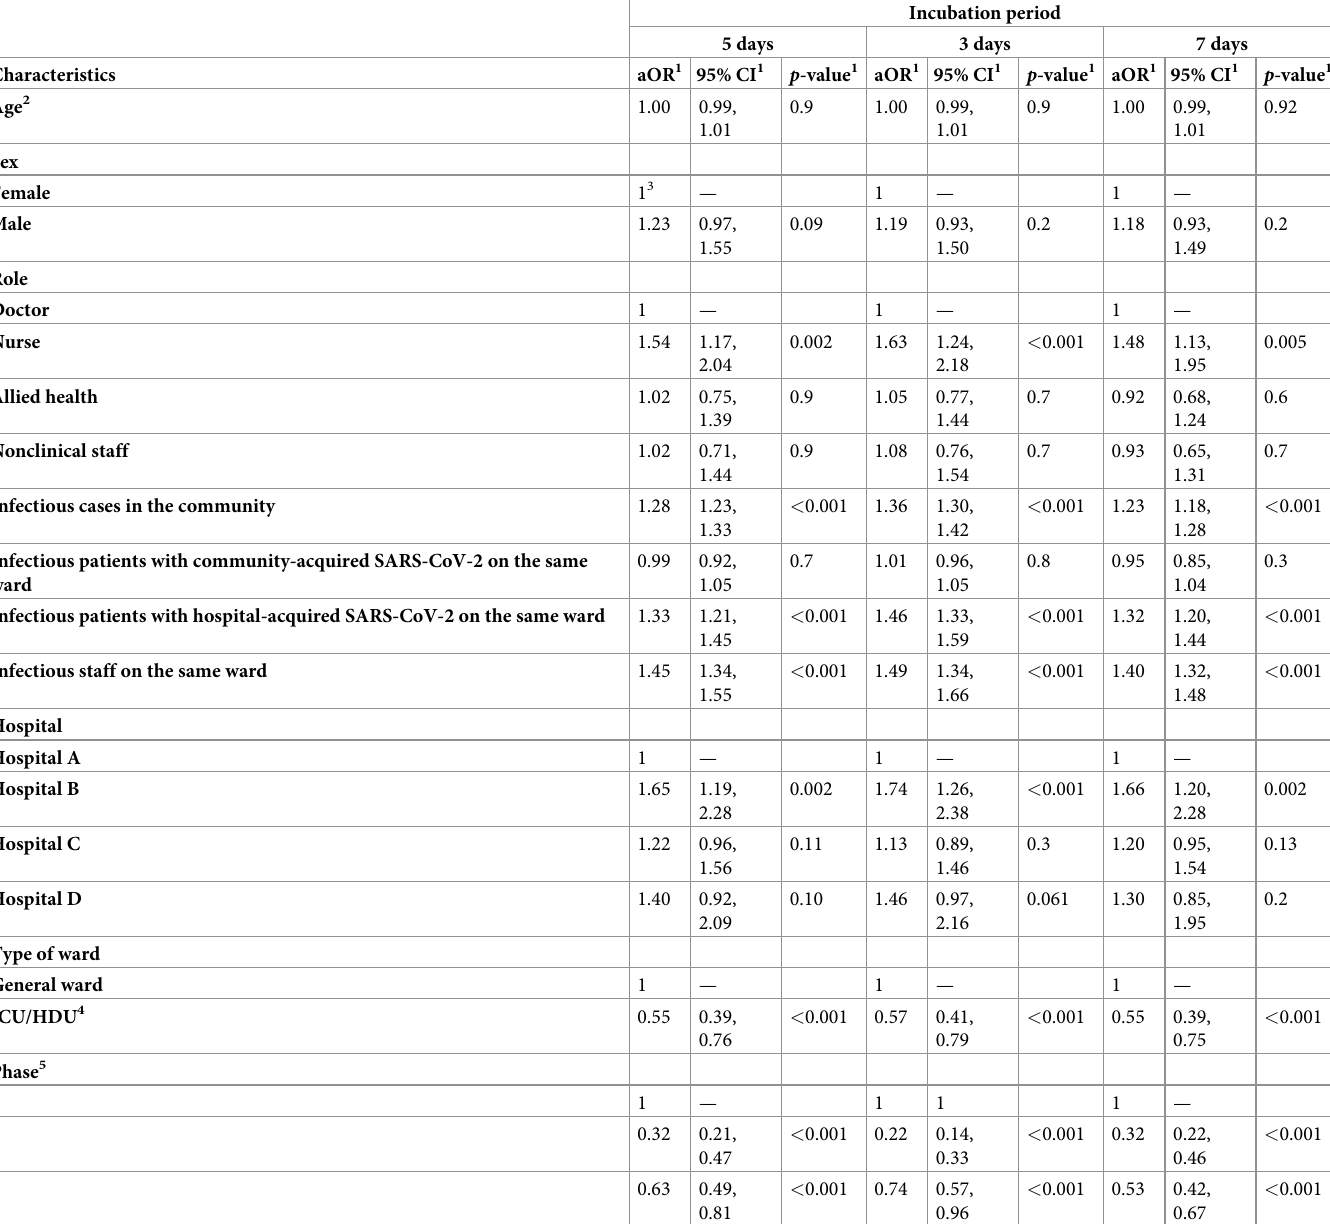
Table 4. Predictors of SARS-CoV-2 infection in HCWs from multivariable logistic